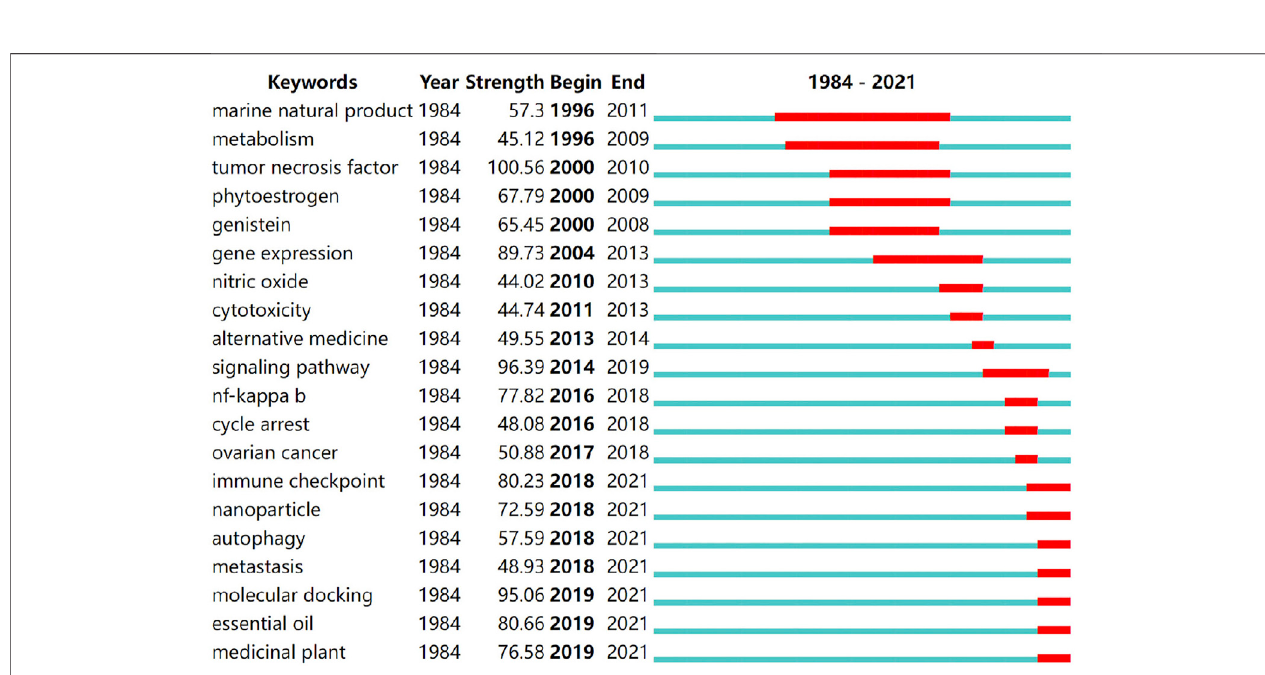
FIGURE 12 | Details of keyword burst detection in scienti fi c articles on anticancer natural products. The keywords “ metastasis, ” “ immune checkpoint, ” “ medicinal plant, ” “ essential oil, ” and “ autophagy ” maintain a large mutation intensity, and the mutation period continues to 2021. “ Begin ” represents the start time in keyword mutation, “ End ” represents the end year of the mutation, and “ Strength ” represents the keyword mutation strength. The larger the value, the greater is the frequency of keyword fl uctuation during this time. The red area represents the time length in keyword mutation.